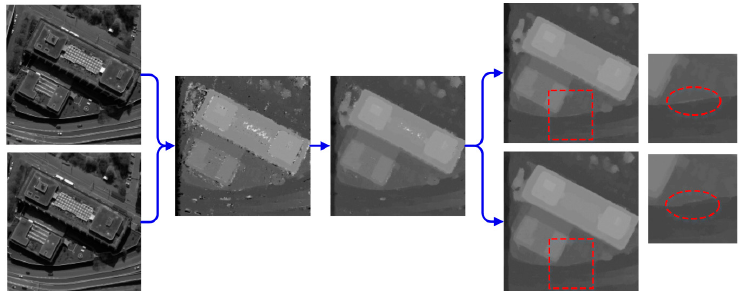
Figure 3. The dense matching results of different processing stages for a local area (Column 1: original stereo pair, Column 2: cost aggregation results, Column 3: speckle-filtering results, Column 4: above shows the results from guided median filtering and below shows the results from traditional median